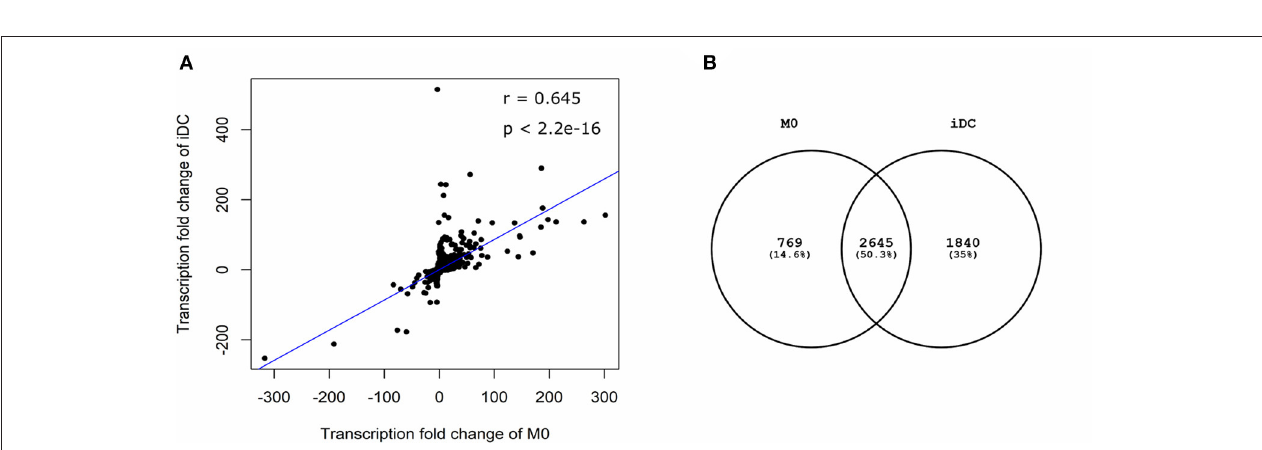
FIGURE 1 | The morphologies of THP-1 monocytes and their derived macrophage-like cells at resting stage (M0) and immature dendritic-like cells (iDC) can be distinguished from each other. THP-1 monocytes were non-treated or differentiated into M0 or iDC in a 24 well-plate and analyzed under the microscope. Scale bar is 20 µ m. Representative pictures of repeated differentiation experiments were shown.